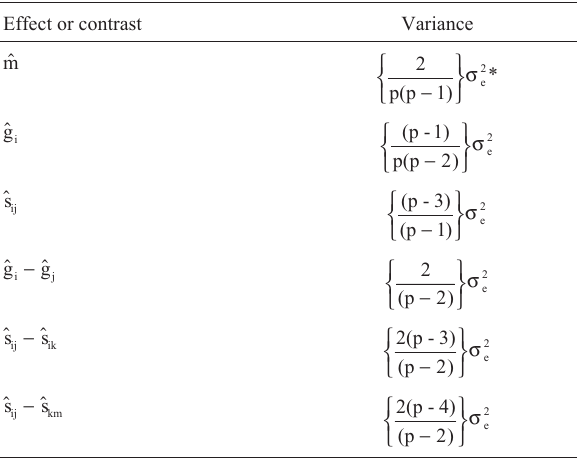
Table 4 - Variance of effects and contrasts between effects of the general combining ability and specific combining ability. Effect or contrast